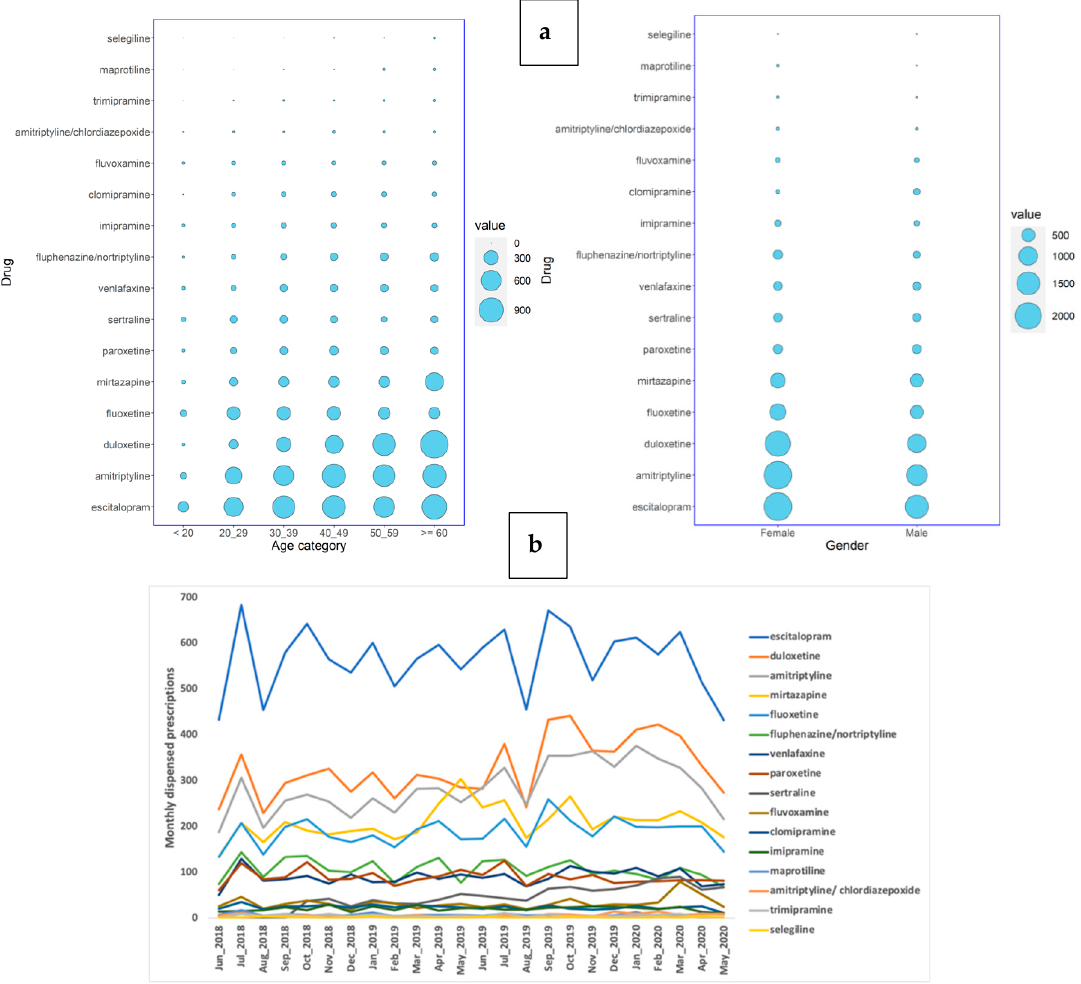
Figure 1. ( a ) The distribution of the number of Qatari patients receiving prescriptions of antidepressants over a period of 2 years in all the HMC/PHCC hospitals stratified by age or gender, and ( b ) the number of prescriptions of antidepressants dispensed over a period of 2 years in the HMC/PHCC hospitals, with the number of prescriptions dispensed monthly on the Y -axis and the months on the X